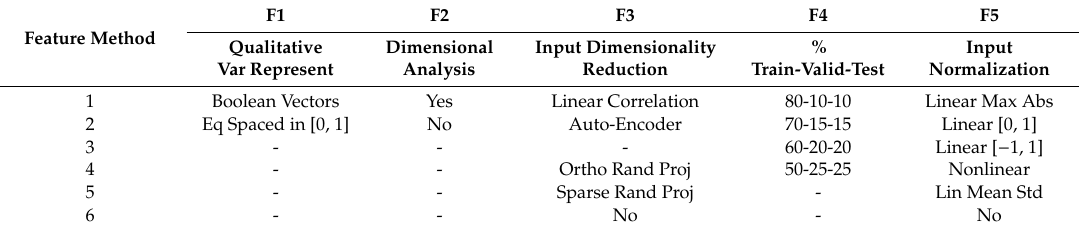
Table 3. ANN features 1 through 5.